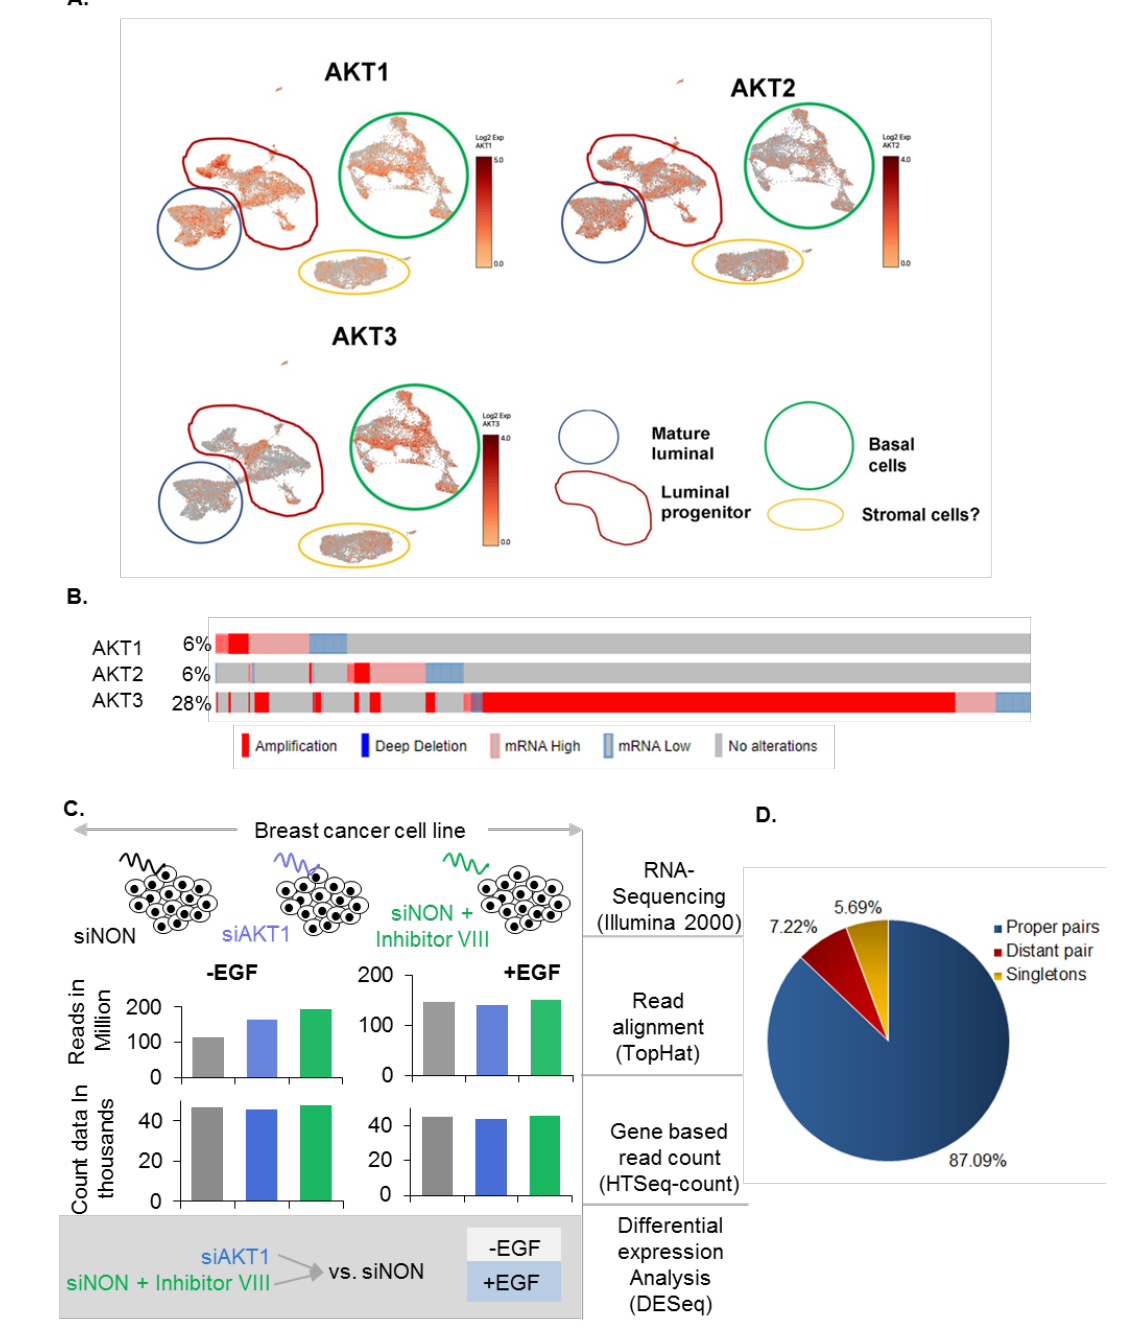
Figure 1. Expression of AKT isoforms and experimental strategy. ( A ) AKT1, AKT2, and AKT3 mRNA at the single-cell level of breast tissue. The image was generated using a recently published healthy breast atlas [38]. Expression of AKT1 and AKT2 was found to be widespread compared to AKT3. For example, AKT3 was expressed at a higher level in many subclusters of basal cells and in subcluster 4 of the luminal progenitor, but least in the mature luminal cells. The identity of the cells in yellow was suspected to be stromal in nature. ( B ) Expression of AKT isoforms in METABRIC datasets. ( C ) An overview of the analysis workflow, including the steps and the method followed to analyze the data and the numeric figures related to each step in the workflow. ( D ) Pie chart shows the average percentage of reads mapped to the human genome (hg19, Ensemble